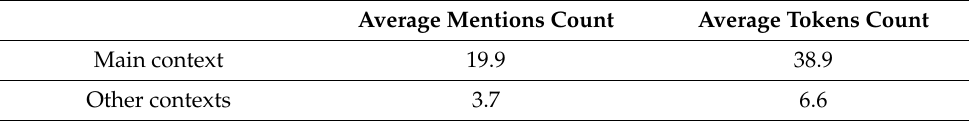
Table 2. Average lengths of contexts in the corpus.